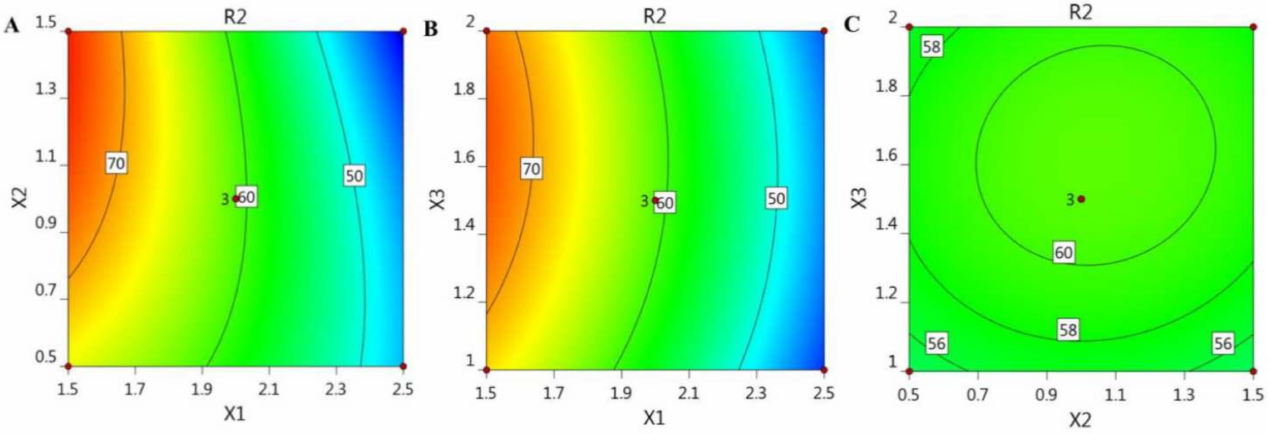
Figure 5. 2D contour graphs signifying the influence of the independent factors ( A ) X 1 and X 2 , ( B ) X 1 and X 3 , and ( C ) X 2 and X 3 on in vitro release response (R 2 ).